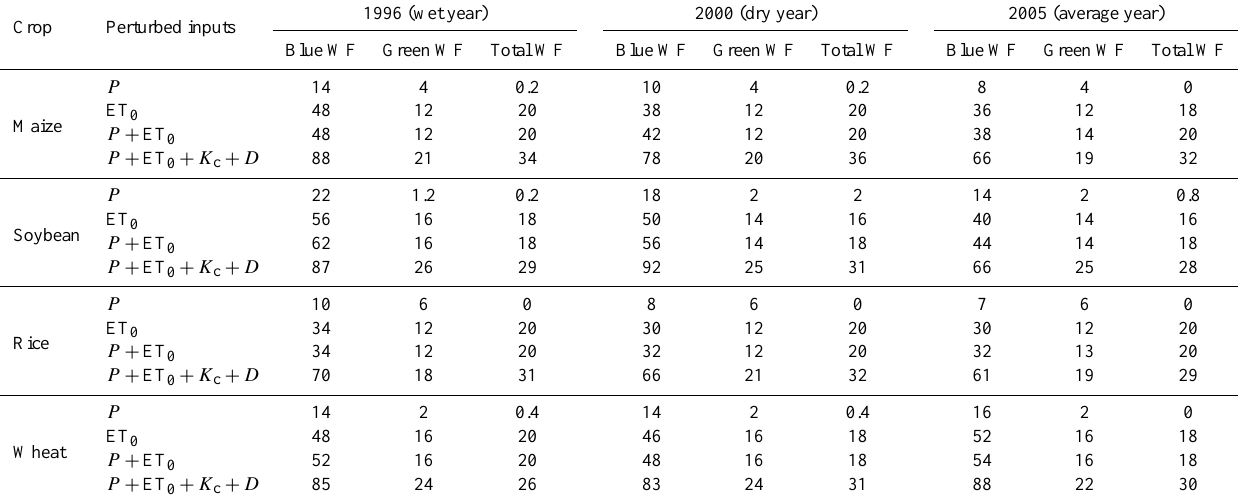
Table 4. Values of 2 × standard deviation for the probability distribution of the blue, green and total WF of maize, soybean, rice and wheat, expressed as % of the mean value, from the Monte Carlo